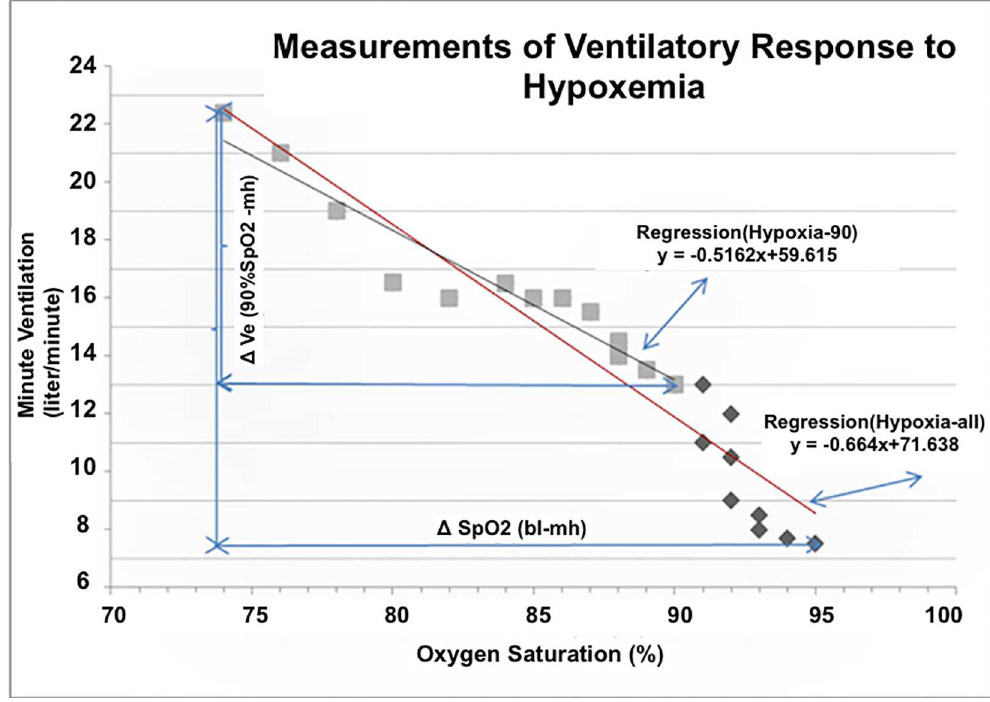
Fig 1. Measurement of ventilatory response to hypoxemia. Illustration of 4 metrics to calculateventilatory responseto hypoxemia(HVR): Hypoxia-all, Hypoxia-90, Regression (Hypoxia-all ) and Regression (Hypoxia-90 ). The first two variableswere calculatedby taking the increase in minute ventilation ( Δ V e ) betweenbaselineand maximal hypoxemia(mh) and dividingit by the corresponding changein SpO 2 ( Δ SpO 2 ). Baseline minute ventilation differed for Hypoxia-alland Hypoxia-90. In Hypoxia-allbaselineminute ventilation was the minute ventilation at the beginningof the study (bl). In Hypoxia-90 baselineminute ventilationwas the minute ventilation measuredat 90% saturation (90%SpO 2 ). Hypoxia-allwas calculatedusing the equation